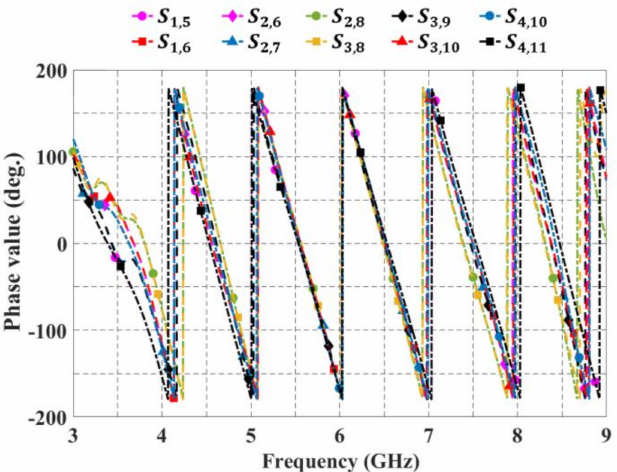
Figure 9. Phase response versus frequency for the block of 4 × 7